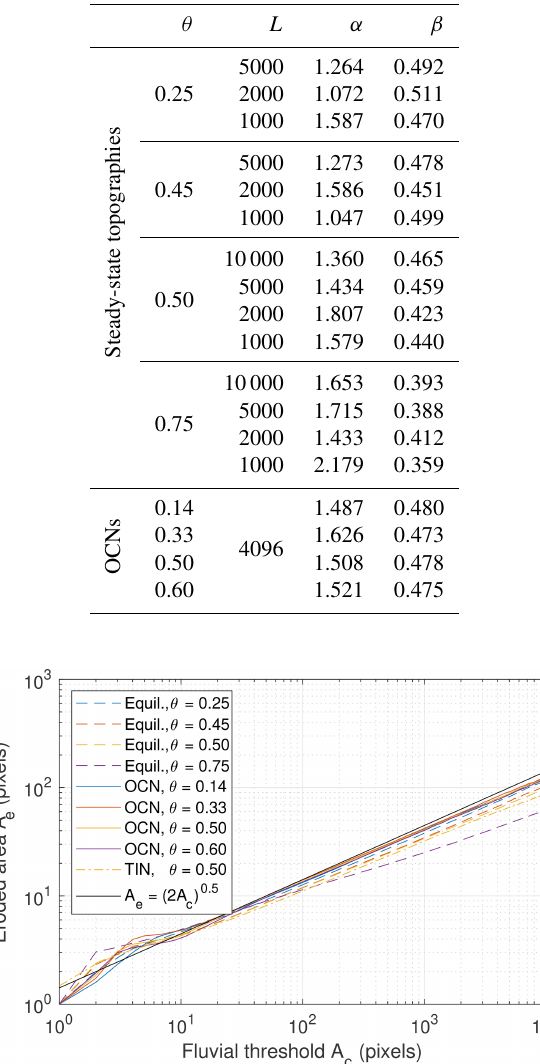
Table 1. Parameter values of the power-law relation between eroded area and fluvial threshold (Eq. 14) obtained from different simulated drainage networks on regular lattices with L × L nodes.